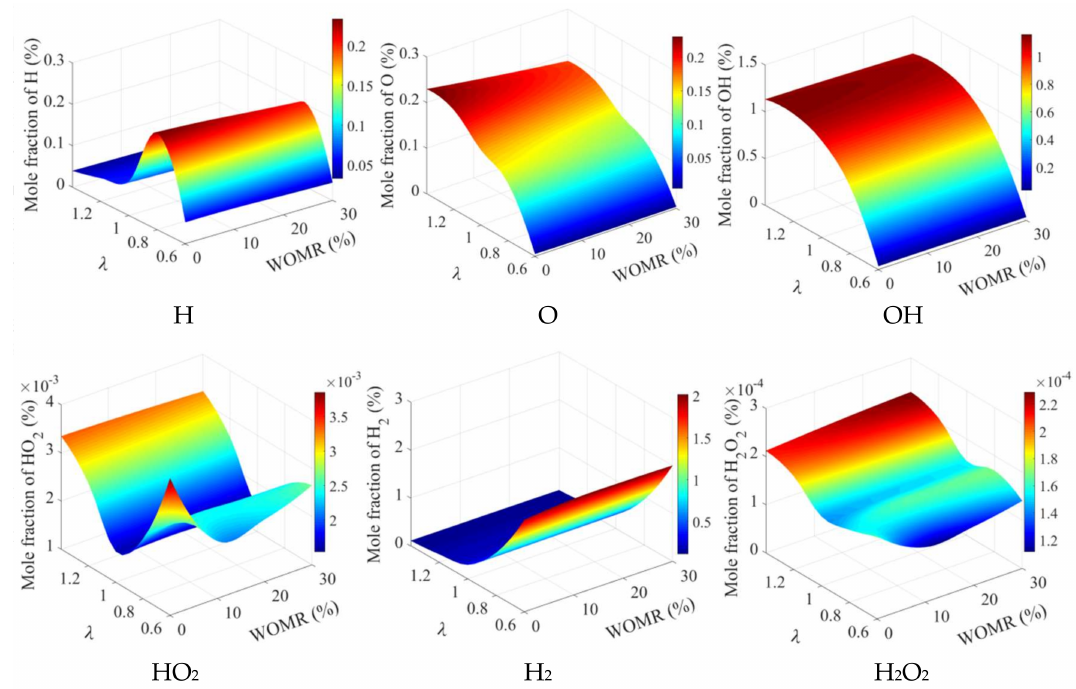
Figure 5. Mole fraction of free radicals corresponding to maximum rate of production of NO.